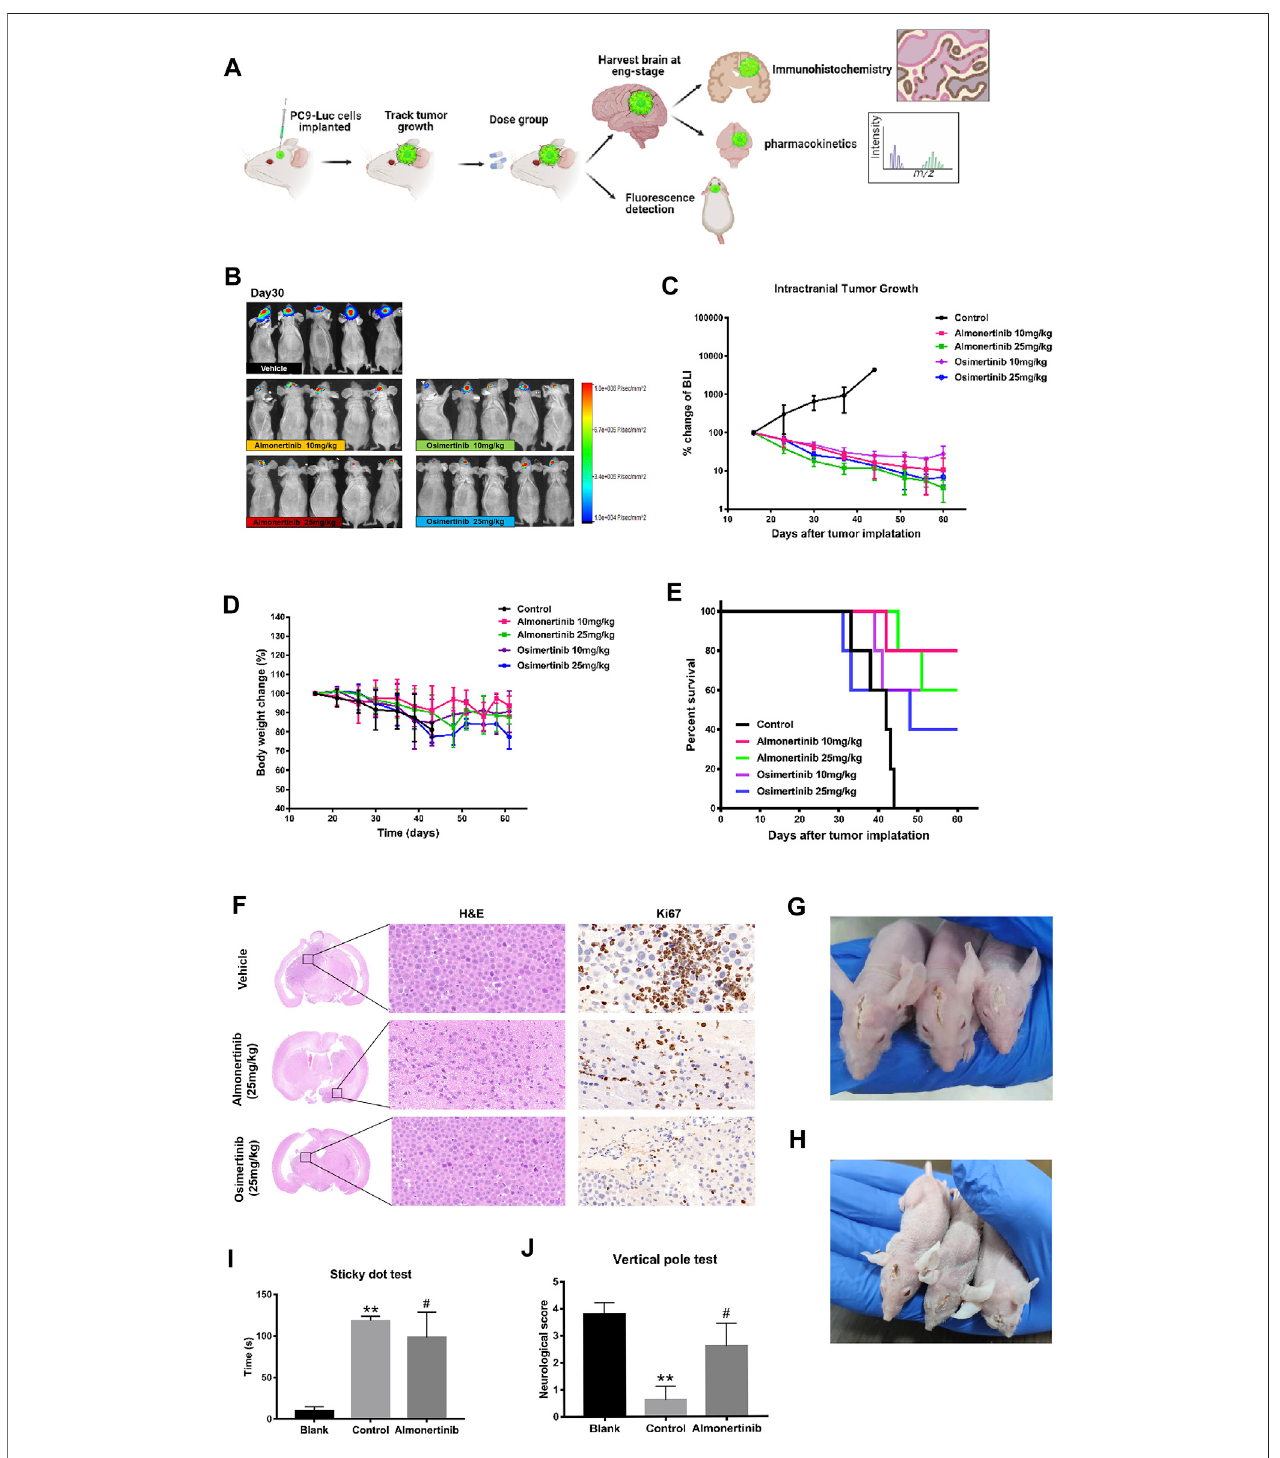
FIGURE2| Anti-tumor effect ofalmonertinib inPC9-LUC brainmetastatic tumor model. (A) Establishmentofabrainmetastatic tumor model ofnon-smallcelllung cancer; (B) Two weeks after the injection of PC9-LUC, the animals were treated with almonertinib or osimertinib once daily. Almonertinib 10 and 25 mg/kg (Qd) and osimertinib 10 and 25 mg/kg (Qd) were used to treat PC9-LUC brain metastatic tumor mice. Tumor bioluminescence (C) , body weight (D) , and overall survival rate (E) were observed. (F) The expression of Ki-67 in the brain tissue was detected by hematoxylin-eosin and immunohistochemical staining. (G,H) Images of brain metastasesinmiceafteradministration; (I,J) neurologicalscoreofmicewithbrainmetastases.Scalebar,50 μ m.Dataarepresentedasmean ± SEM( n (cid:2) 5/group).** p < 0.01 vs. vehicle control.